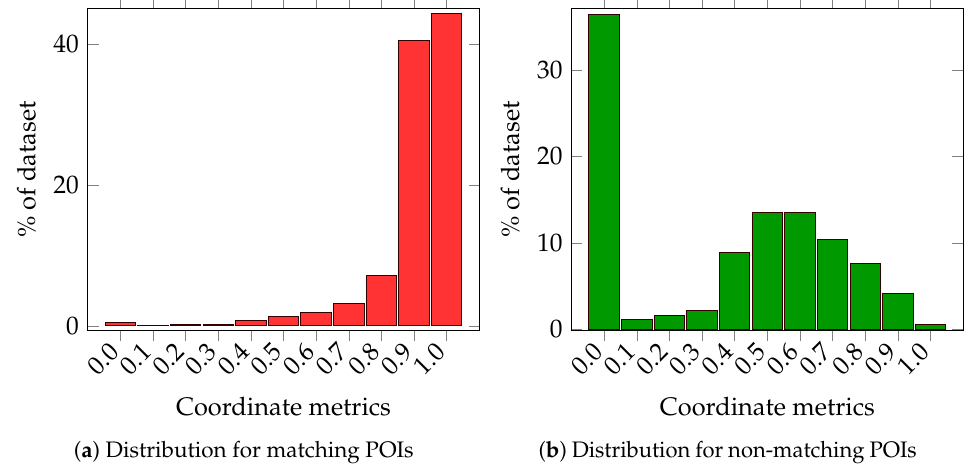
Figure 10. The distribution of metrics coordinates in the training set for matched and mismatched